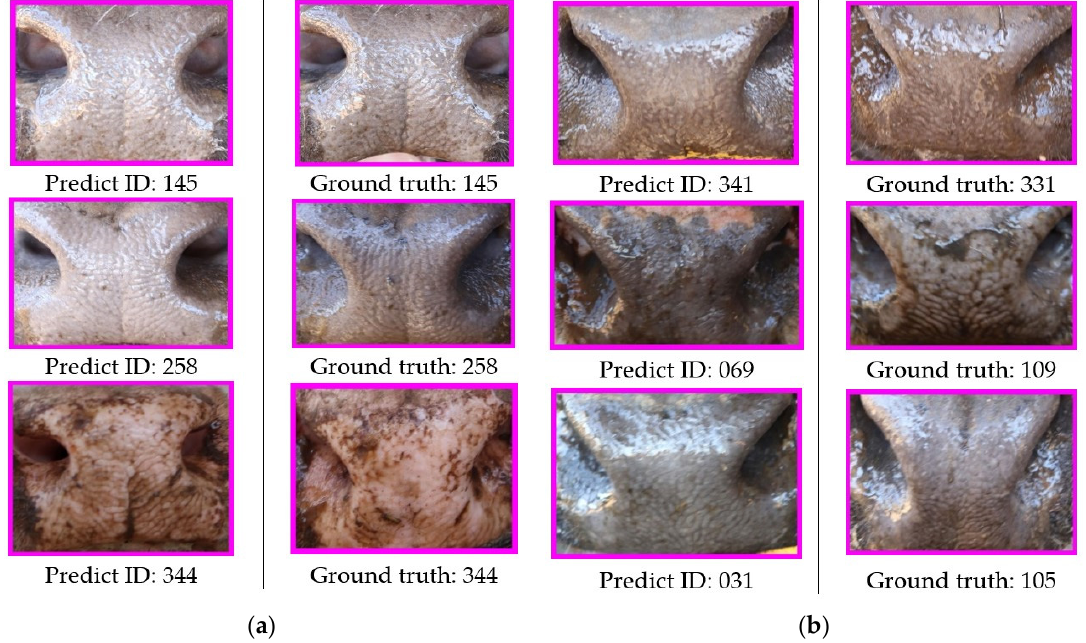
Figure 8. True and false identification examples from the ResNet-50 muzzle pattern identifier model: ( a ) true identification examples and ( b ) false identification examples.